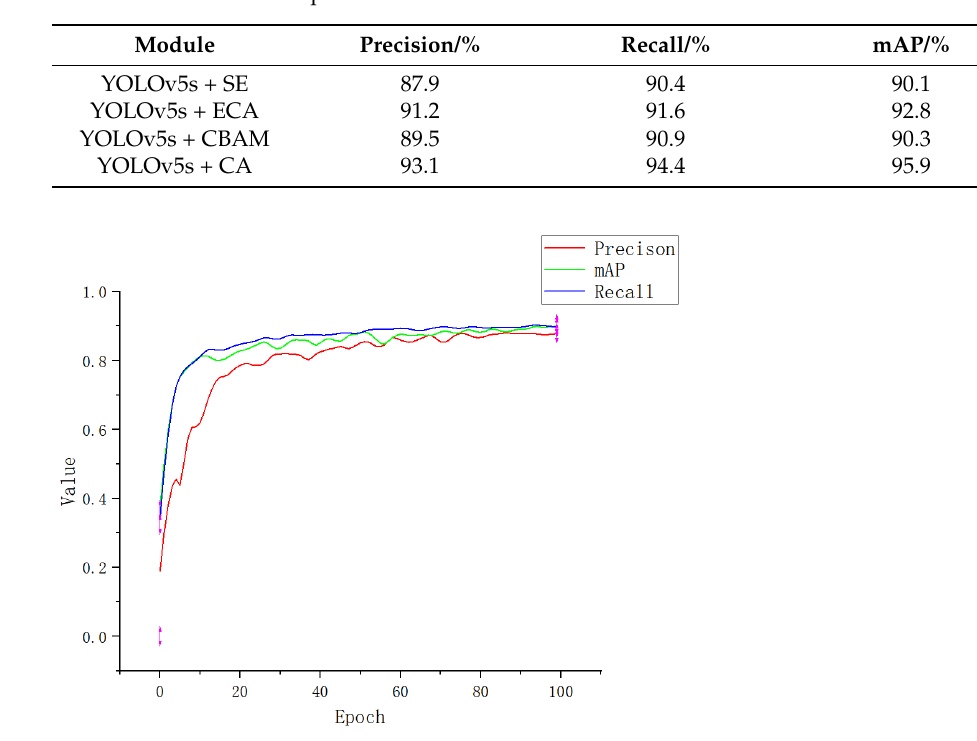
Table 2. Performance comparisons of different models.